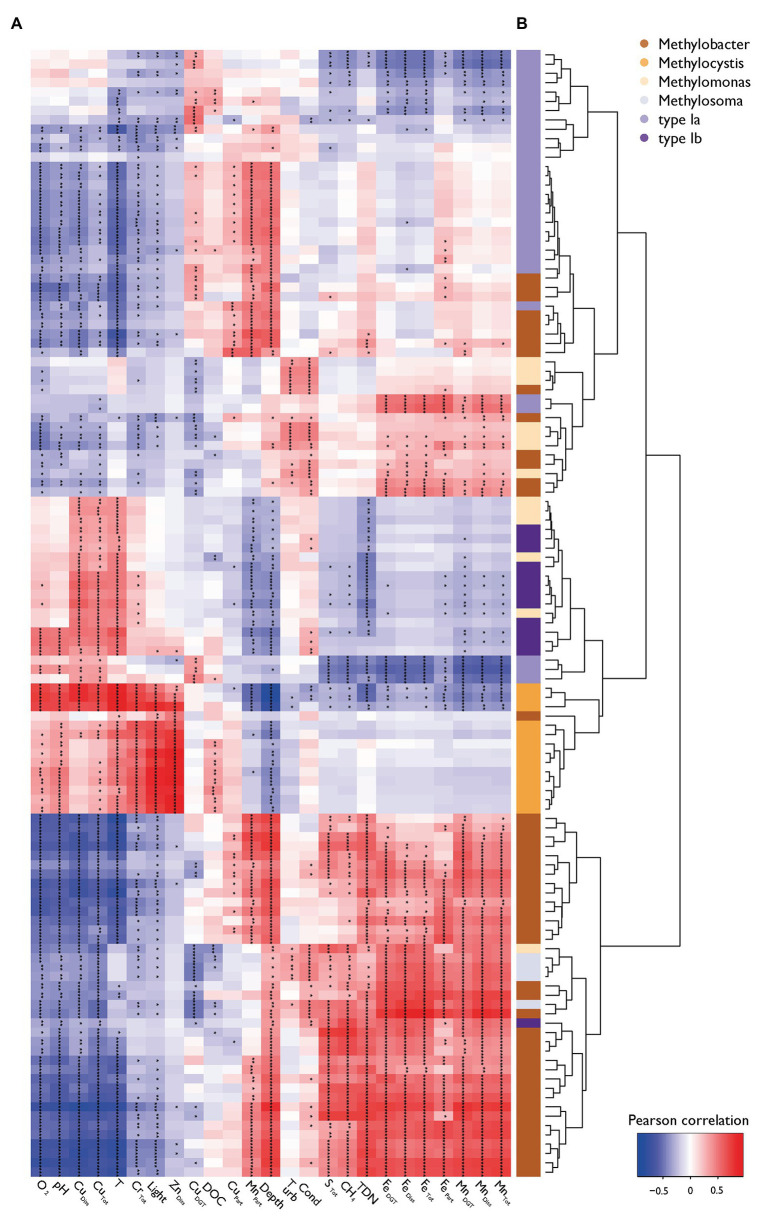
Pearson correlation heatmap of MOB (pmoA) and environmental variables. (A) The heatmap of the Pearson correlation of specific MOB OTUs abundance with physico-chemical variables is ordered by its column and row means. Asterisks indicate levels of Holmes corrected values of p (*
p < 0.05, **
p < 0.01, ***
p < 0.001). (B) A hierarchical environmental clustering dendrogram of MOB and their color coding according to their taxonomic affiliation are depicted on the right.